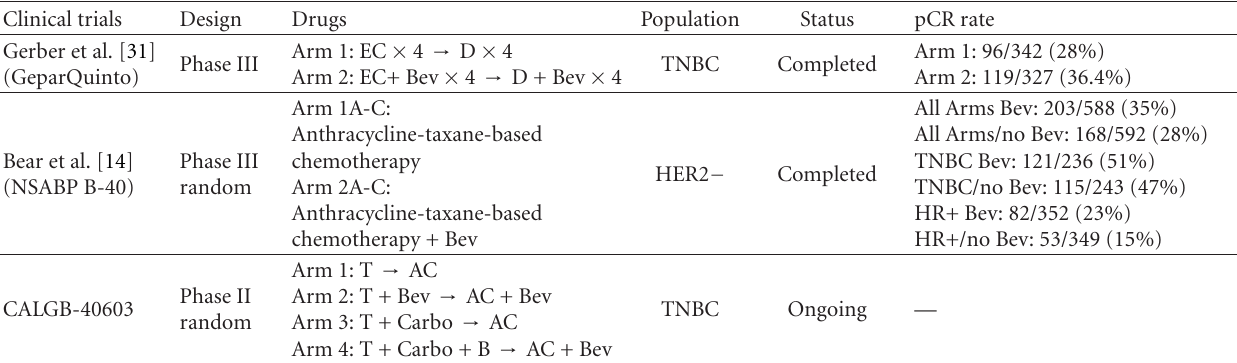
Table 2: Summary of neoadjuvant bevacizumab-based chemotherapy trials. ∗